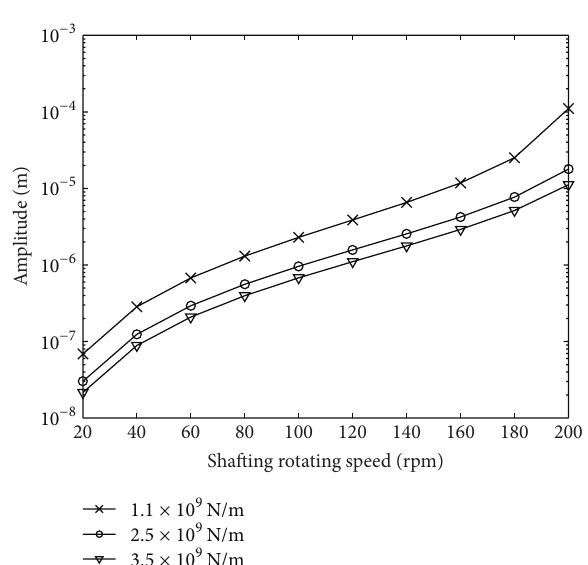
Figure 13: Steady response of thrust bearing induced by thrust load at blade passing